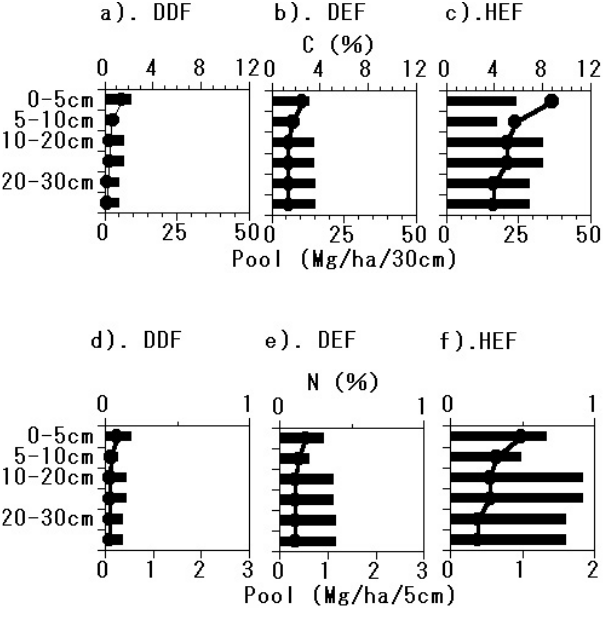
Seasonal Change of N Fluxes in Three Contrasting Dry Tropical Forests Type of